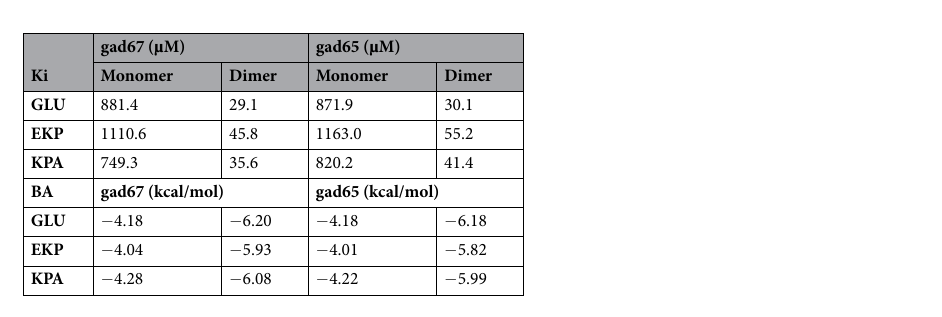
Table 1. Binding affinity (BA) in Kcal/mol and the Ki values in µ M resulting from docking of GLU (glutamate), EKP and KPA in both monomeric and dimeric models of enzymes gad67 and gad65 of Danio rerio . EKP (values in bold) shows similar results in comparison to GLU and